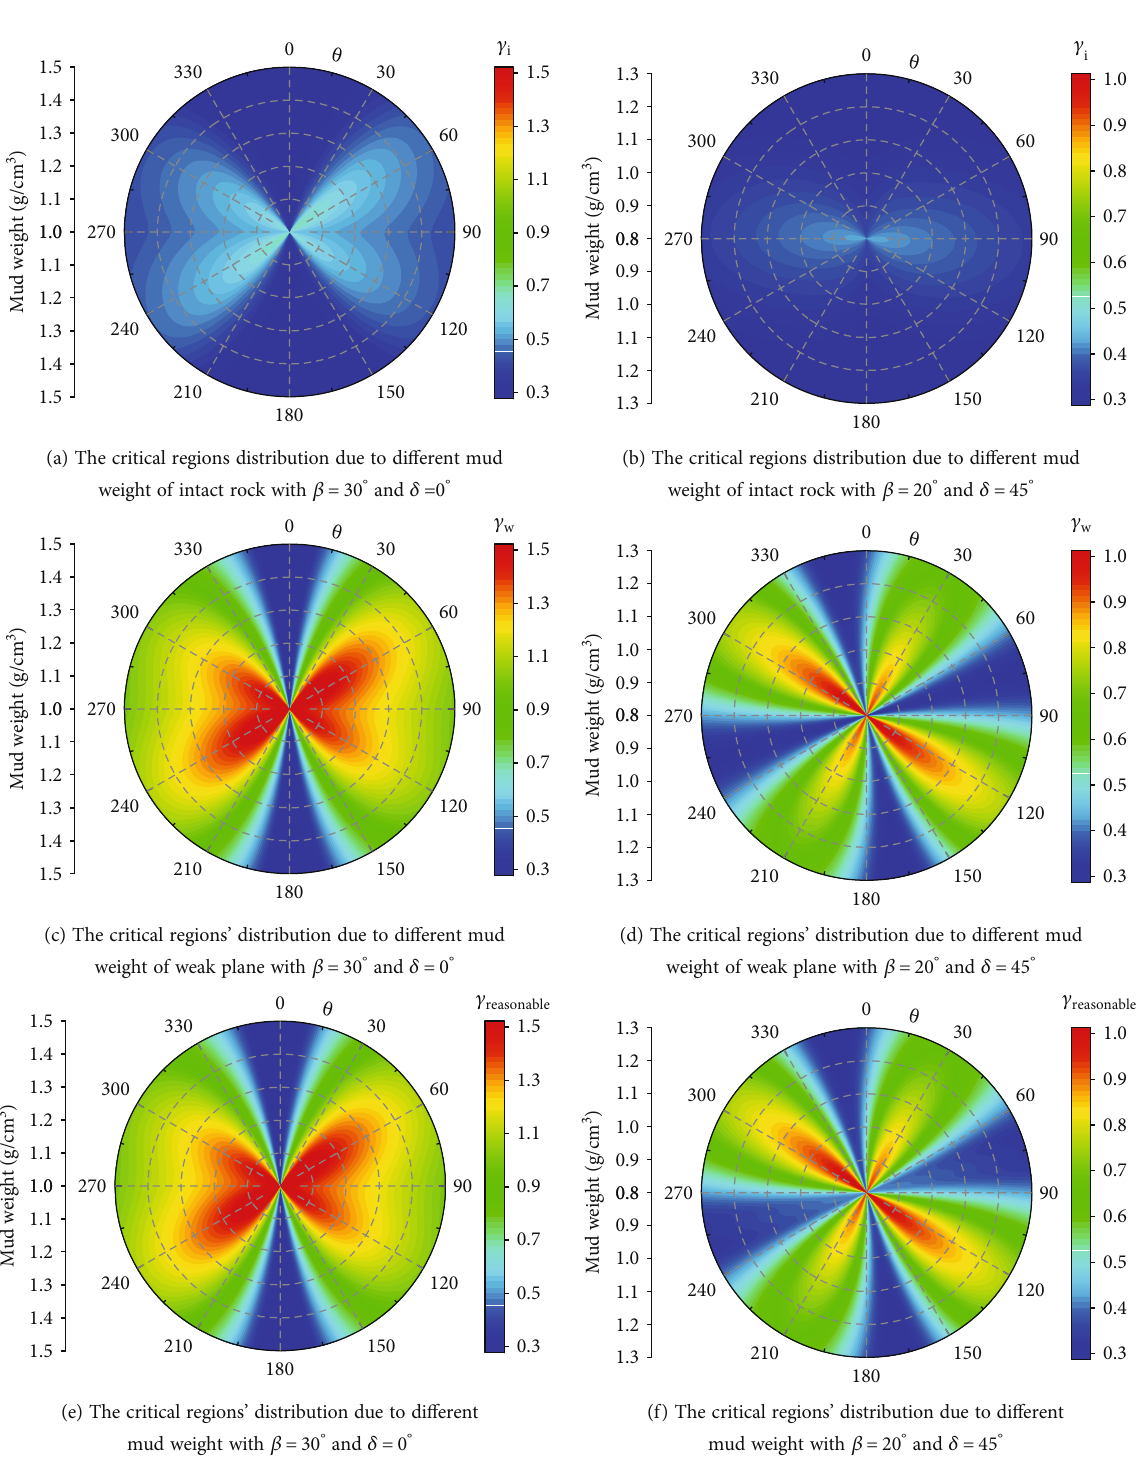
Figure 7: Borehole stability analysis of reservoir shale with considering weak